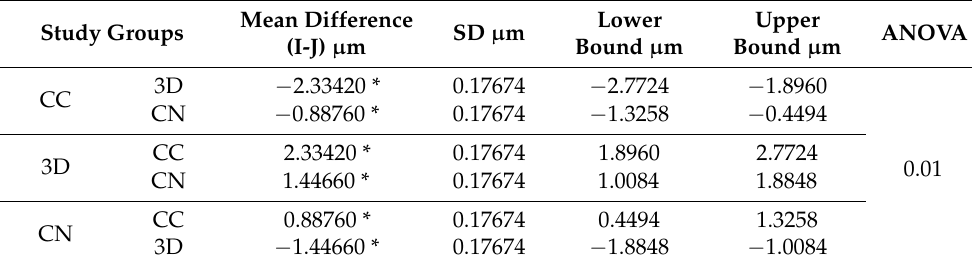
Table 4. Statistical comparison of the study groups for surface